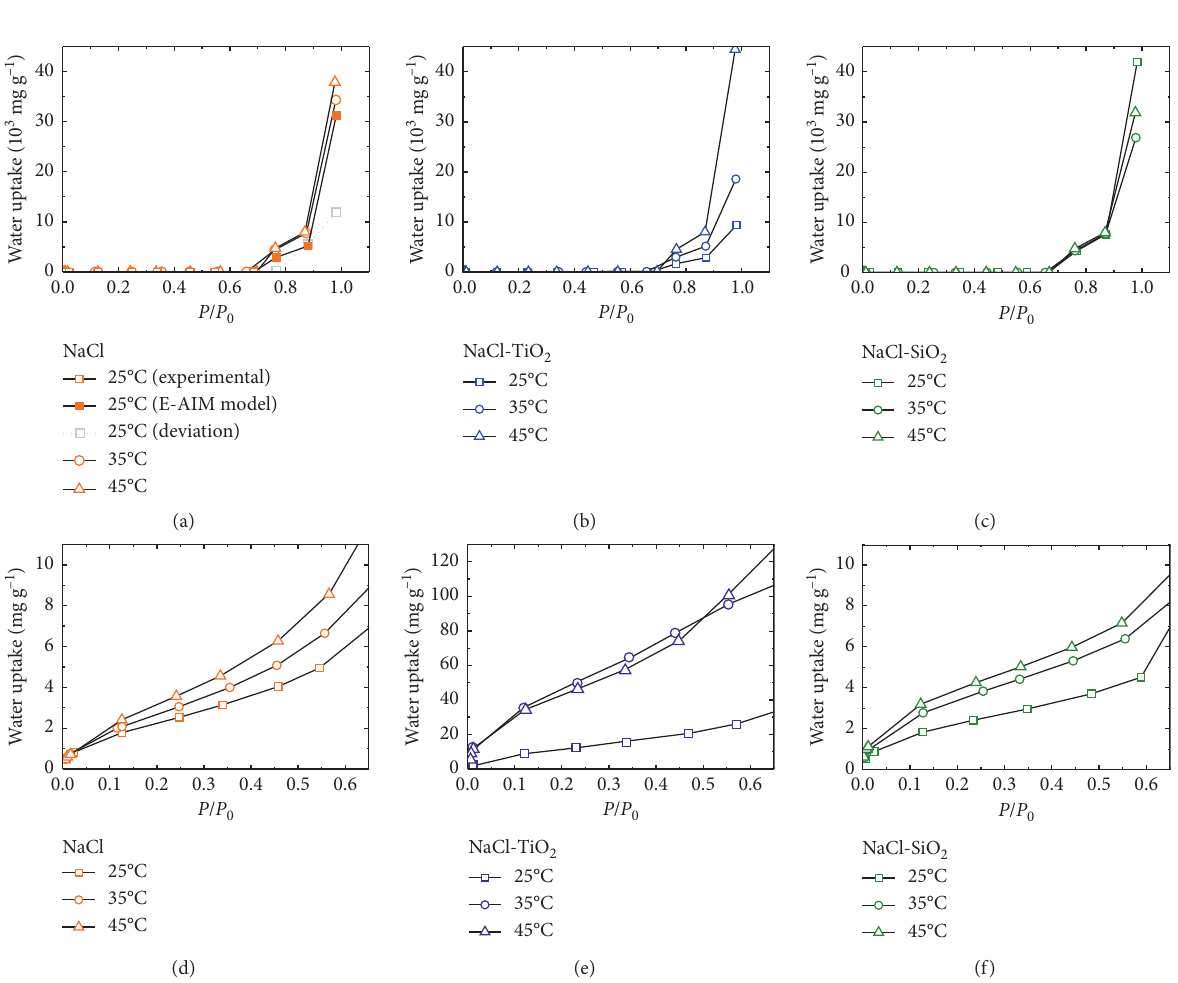
2 ; and (c) and (f) for